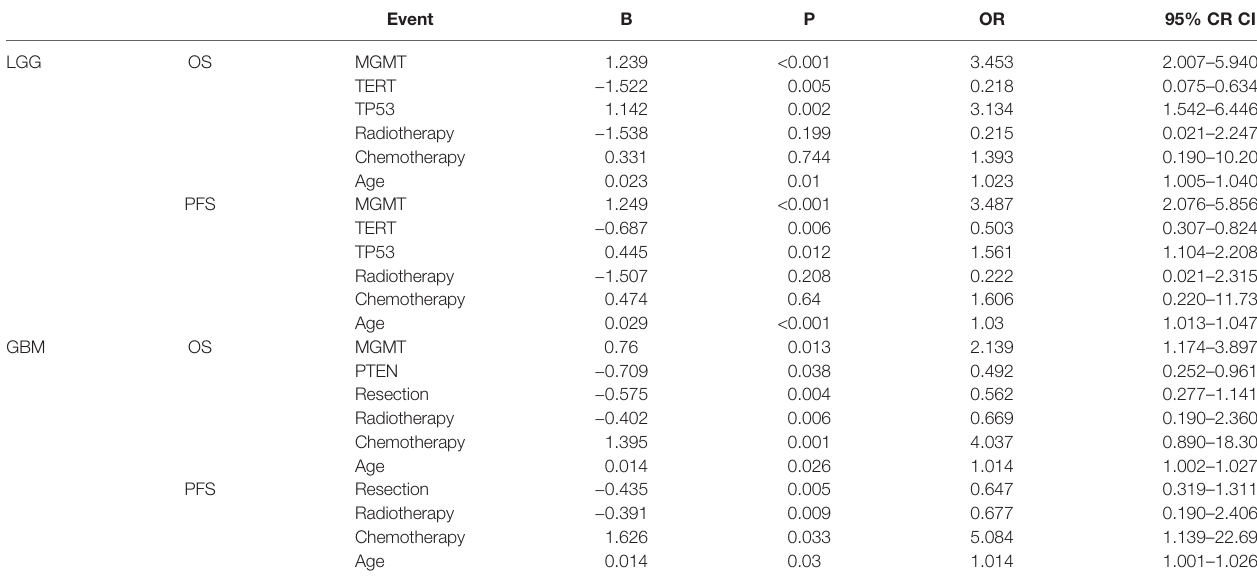
TABLE 2 | Multivariate analysis results for LGG and GBM